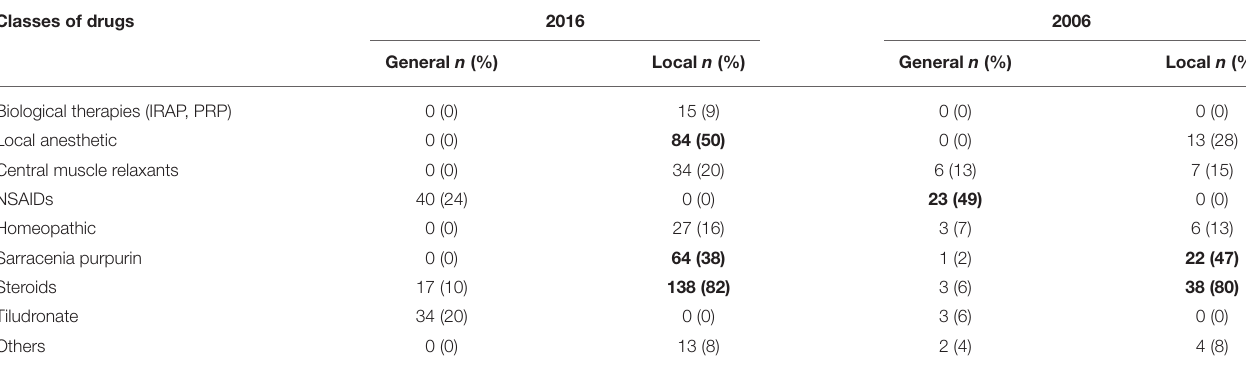
TABLE 8 | Classes of drugs administered to treat back-pain by 2006 and 2016 survey respondents. Classes of drugs 2016